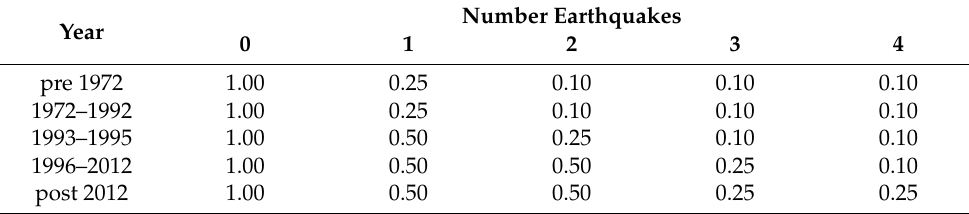
Table 4. Factor B for timber buildings.